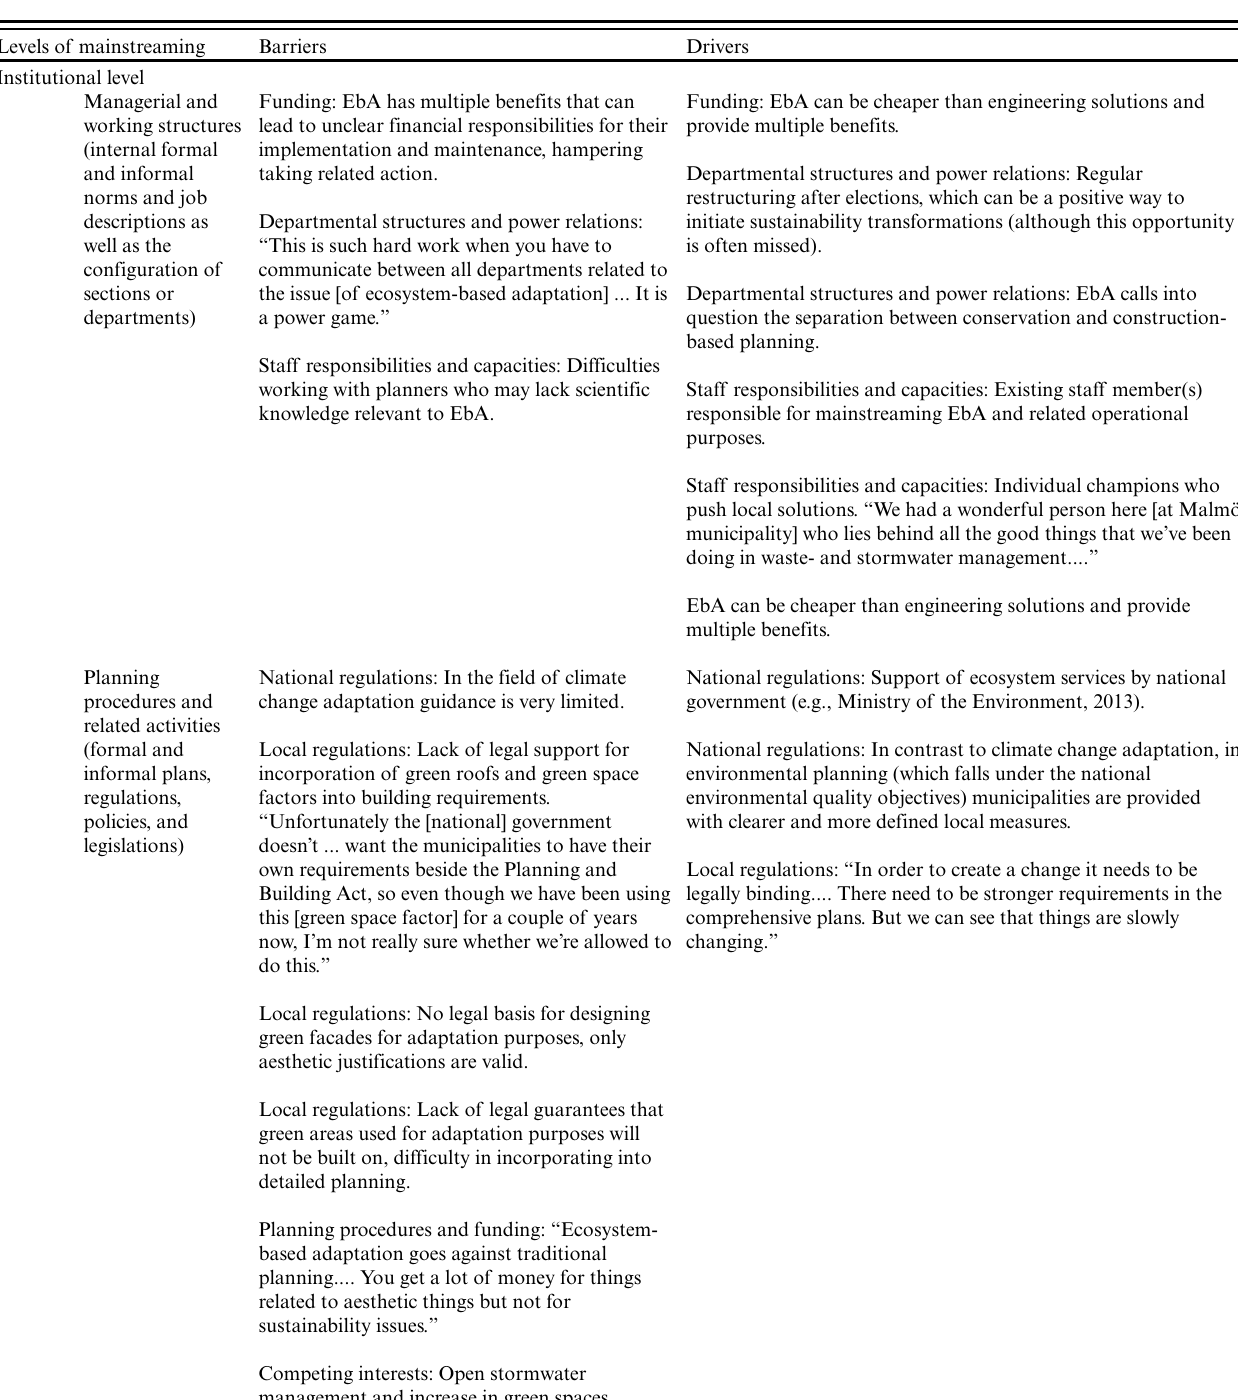
Table 1 . Institutional and interinstitutional driving forces and barriers to the mainstreaming of ecosystem-based adaptation measures that were identified by